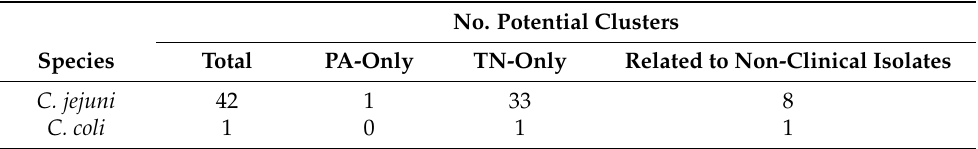
Table 2. Summary of potential outbreak clusters detected using a hqSNP distance threshold of 10 hqSNPs. Complete data are available in Table